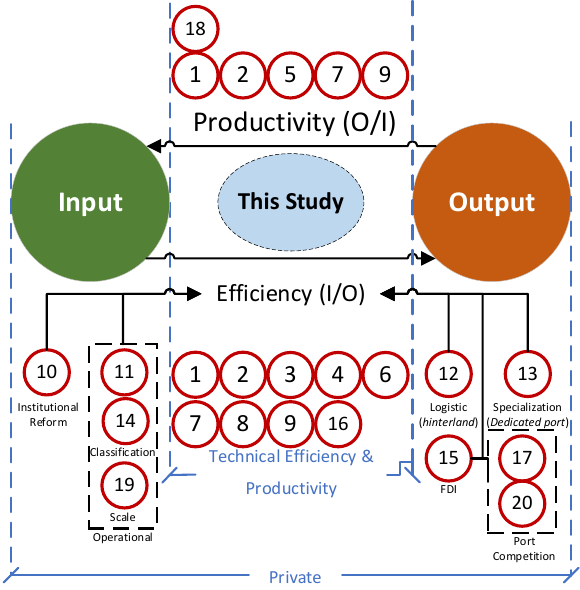
Figure 4: Research Gap Source: Author’s